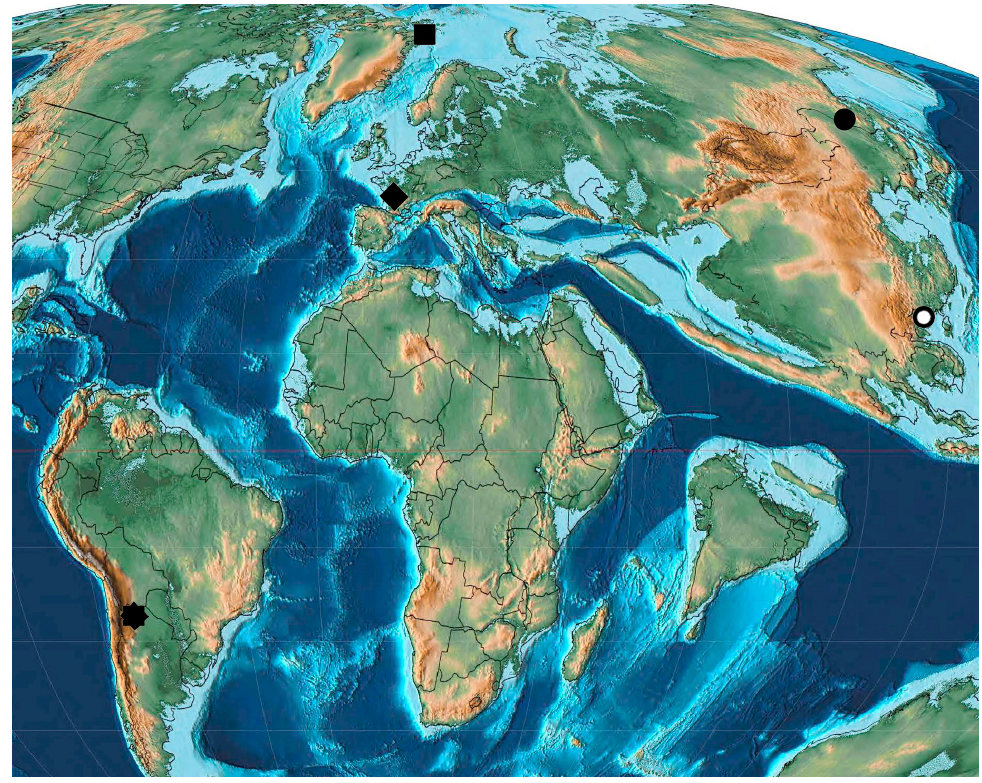
Figure 2. Paleocene Curculionoidea deposits: octagon—Sunchal; square—Starostin; rhombus—Menat; circle—Arkhara; ring—Mirs Bay. Geosciences 2019 , 9 , x FOR PEER REVIEW